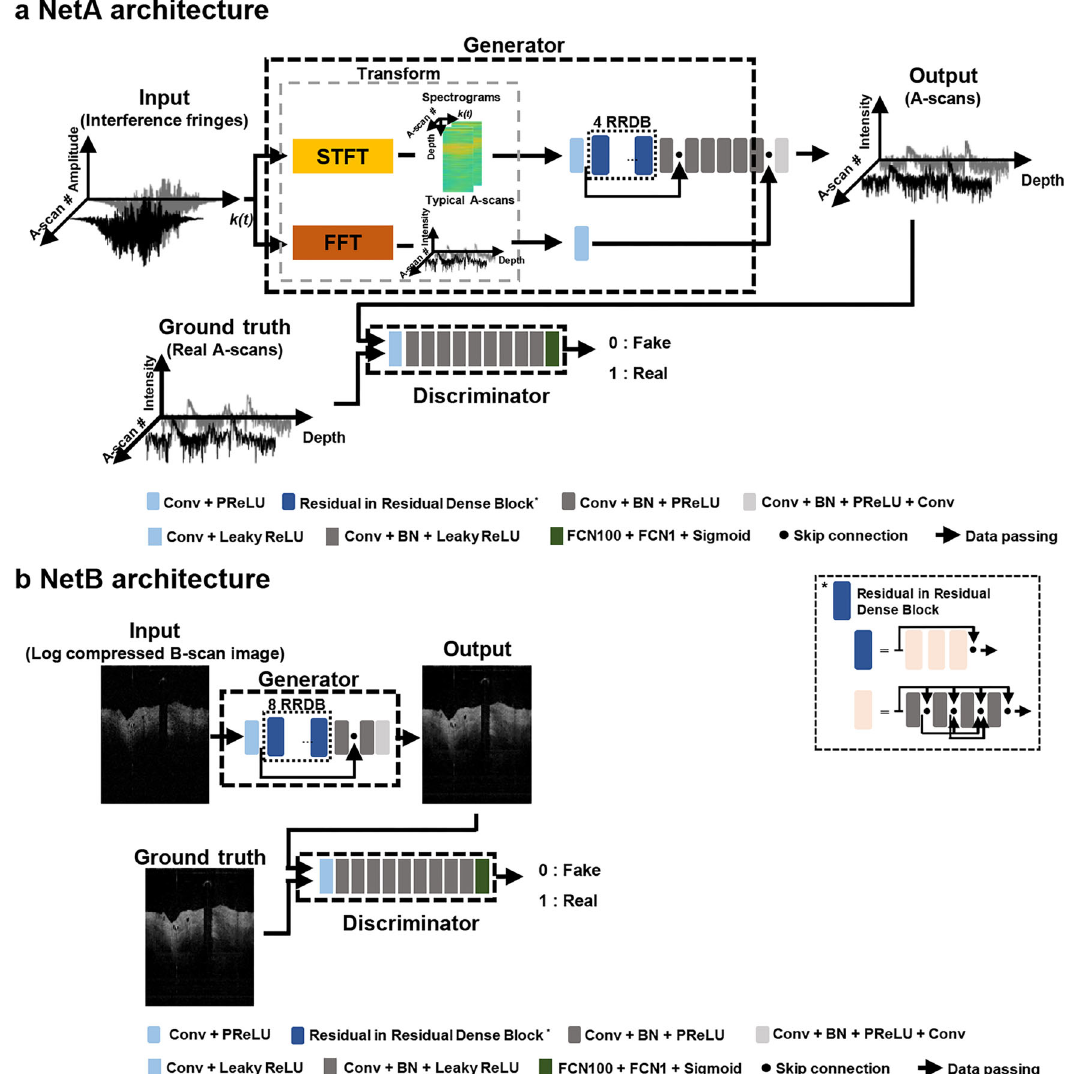
Fig. 6 Network architectures for NetA and NetB. a The generator and discriminator of NetA consist of 13 blocks (comprising 4 Residual-in-Residual Dense Blocks (RRDB) and 1 skip connection block) and 11 blocks (comprising convolutional layers), respectively. b The generator and discriminator of NetB consist of 12 blocks (comprising 8 Residual-in-Residual Dense Blocks) and 11 blocks (comprising convolutional layers), respectively. Each block includes a 2D batch normalization and parametric recti fi ed linear unit (PReLU) activation function. The block in the middle of the fi gure represents